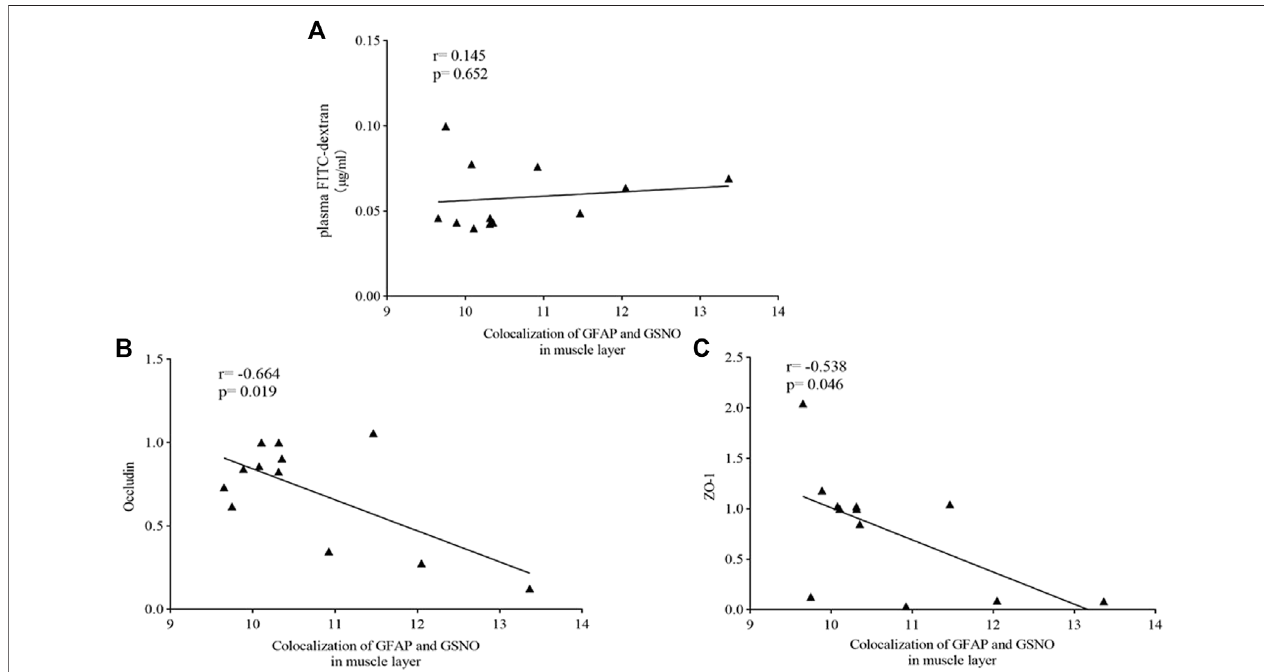
FIGURE 11 | Correlation analysis between the level of EGC-derived GSNO in the muscle layer and intestinal barrier function. Spearman test showed that no signi fi cant correlations were observed between the expression of EGC-derived GSNO and of plasma FITC-dextran concentrations in the muscle layer (A) . an inverse correlation was observed between the level of EGC-derived GSNO in the muscle layer and the expressions of occludin (B) and ZO-1 (C) .